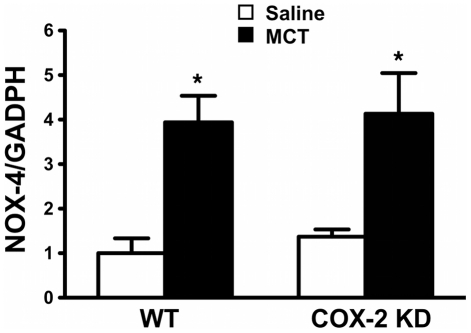
NOX-4 is induced in response to MCT.NOX-4 mRNA expression detected by quantitative RT-PCR in whole lung extracts. Results were expressed as fold-change relative to WT/saline after normalization to endogenous control GADPH. WT/saline, n = 5; WT/MCT, n = 9; COX-2 KD/saline, n = 4; COX-2 KD/MCT, n = 6) *, p<0.05 vs saline.